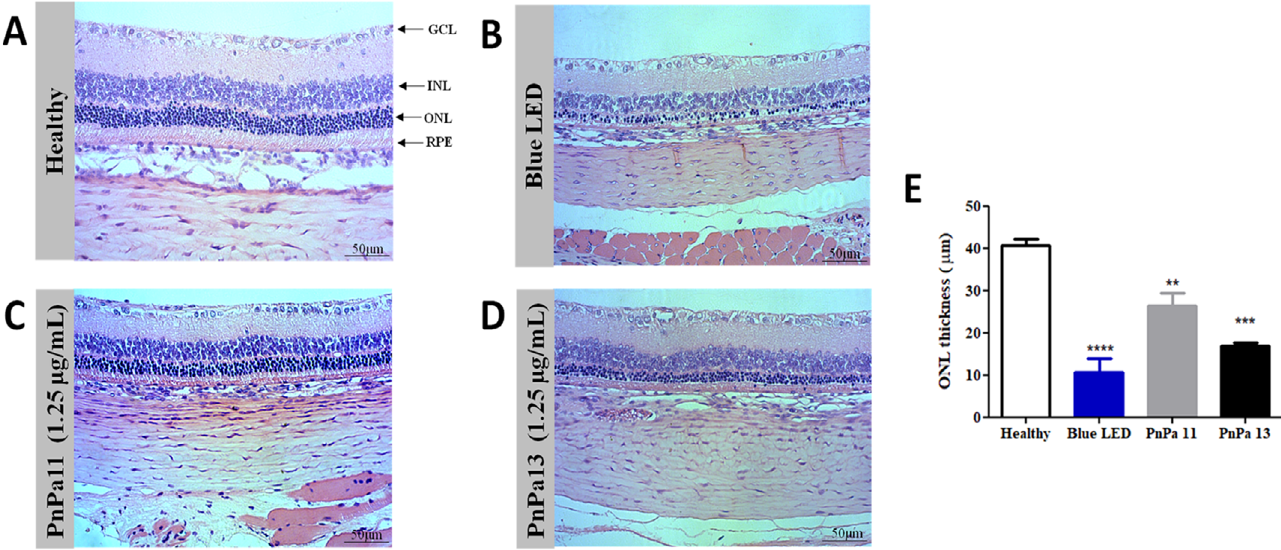
Figure 6. Histological retinal sections analysis. (A) Normal retinal layers in the healthy group compared to (B) blue LED light exposure-induced retinal injuries and treated eyes with (C) PnPA11 and (D) PnPA13. The ONL thickness retina of healthy group was compared to the blue LED light exposure group or treated with PnPa11 (1.25 µg/mL) or PnPa13 (1.25 µg/mL) before blue LED light exposure using one-way ANOVA followed by Tukey post-test. Three measures per slide were performed (n = 3). *Significant difference when compared to healthy group (**p < 0.01, ***p < 0.001, ****p < 0.0001). GCL: ganglion cell layer; INL: inner